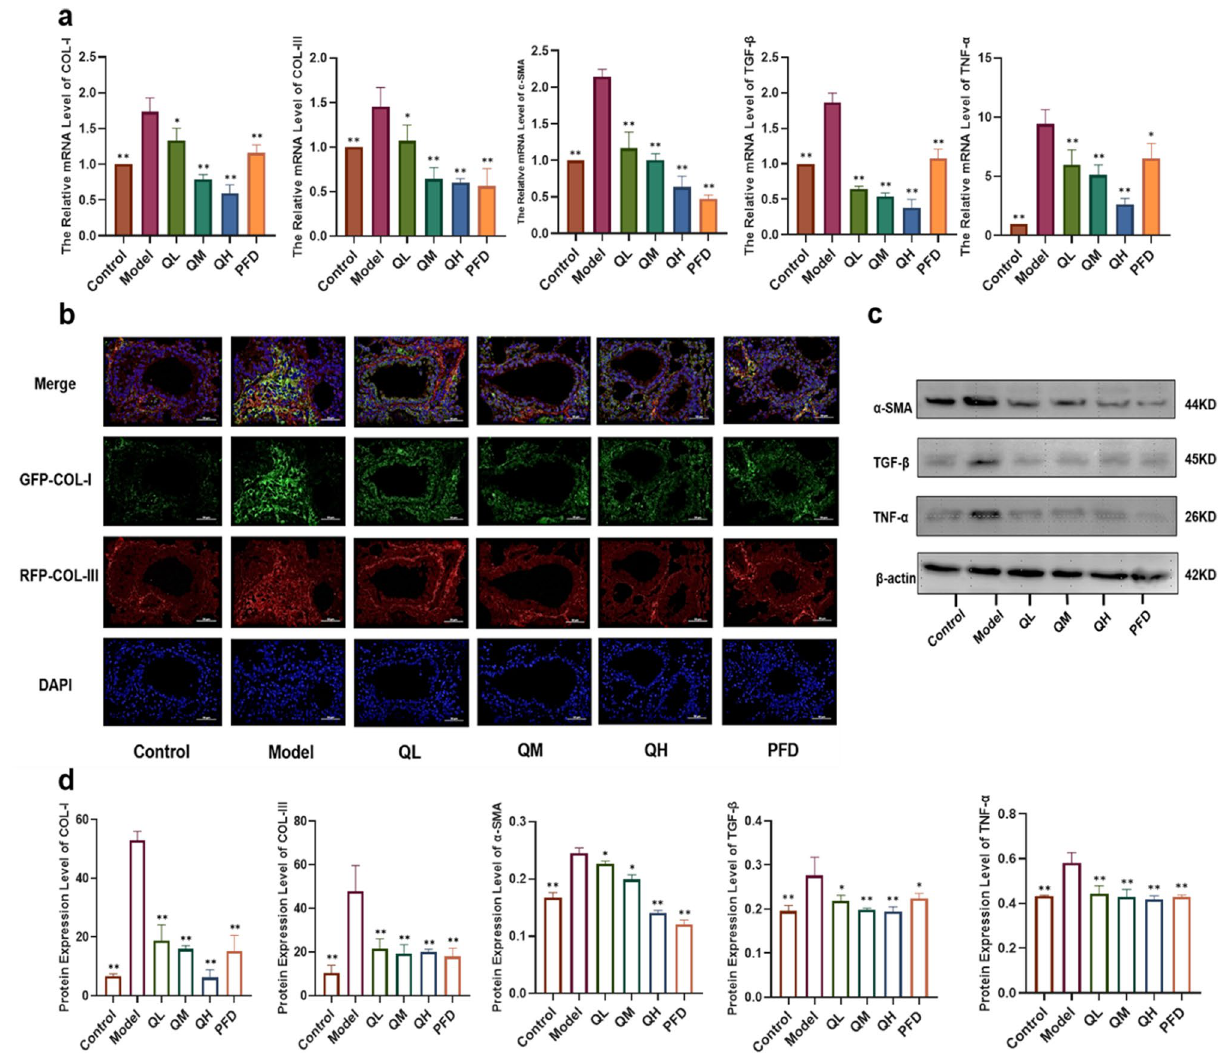
Figure 3. Effects of inflammation and collagen-related indexes in each group. ( a ) The relative expression level of COL-I, COL-III, α-SMA, TGF-β, and TNF-α mRNA levels in pulmonary tissues. ( b ) The location and expression levels of COL-I and COL-III in pulmonary tissues were detected by using an immunofluorescence assay. ( c ) The protein levels of α-SMA, TGF-β, and TNF-α were detected by western blot. ( d ) The quantification and statistical analysis of ( b – d ). (n = 3; data are expressed as mean ± SD. * P < 0.05, ** P < 0.01, compared with Model